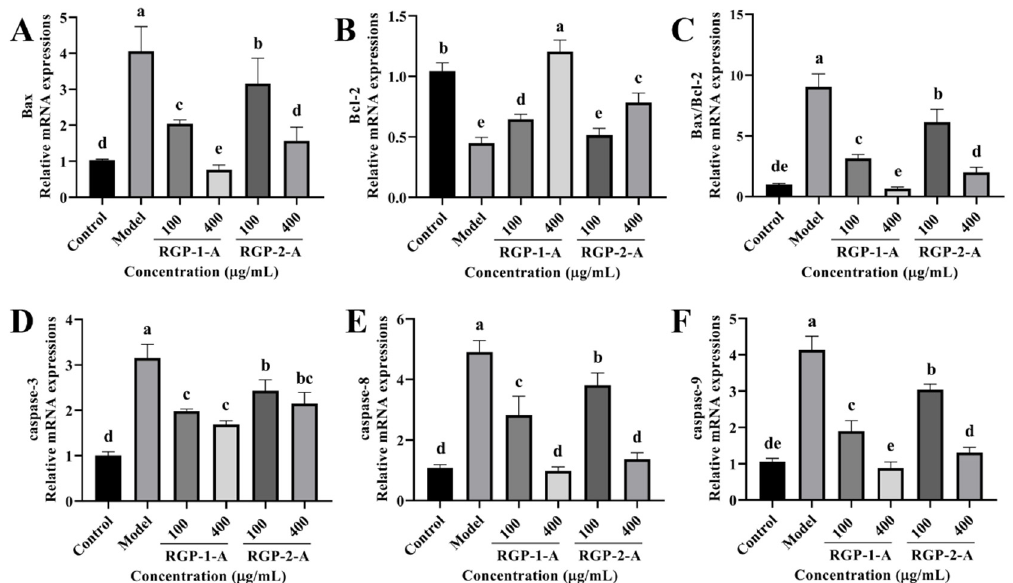
Figure 7. E ff ect of RGP on the relative expression of apoptosis-related genes in IPEC-J2 cells induced by LPS. ( A ), Bax; ( B ), Bcl-2; ( C ), Bax/Bcl-2; ( D ), caspase-3; ( E ), caspase-8; ( F ), caspase-9. RGP-1-A: decolorized pure polysaccharides of RGP obtained using AB-8 macroporous resin; RGP-2-A: decolorized pure polysaccharides of RGP obtained using H 2 O 2 . On the bar graphs, different lowercase letters signify a significant difference ( p < 0.05).